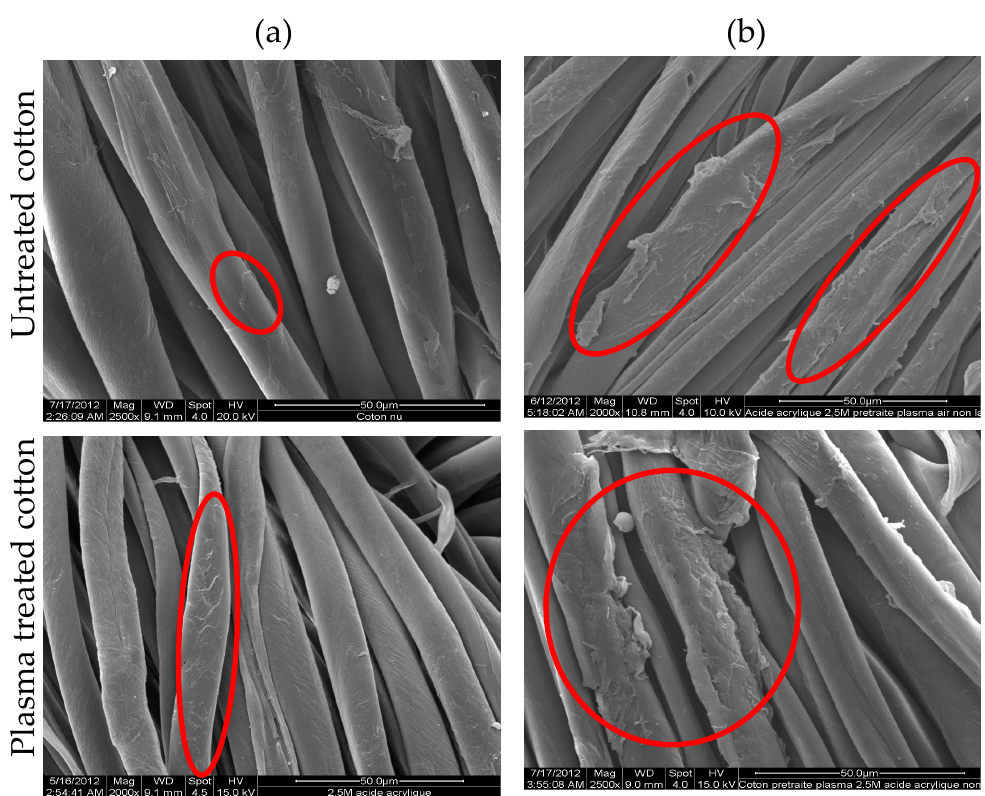
Figure 2. Surface morphology of crude and plasma-treated cotton fabrics ( a ) before acrylic acid deposition and ( b ) after acrylic acid deposition.